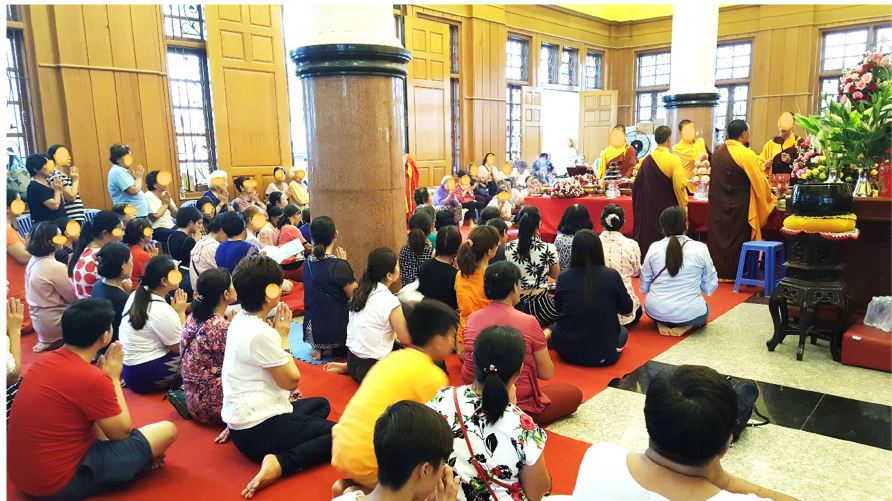
Figure 12. Numerous Yunnanese laity attentively and respectfully participating in a chanting cere- mony at Jingming Chan Si. (Source: Author). Later in the afternoon, monks and laypeople left the monastery and drove to the riverbank, where they conducted the rituals of releasing water lanterns ( Fangshuideng 放 水燈 ) and releasing animals ( Fangsheng 放生 ). I was kindly invited by a young laywoman who had met me previously to go to these ceremonies in a car with three other women.